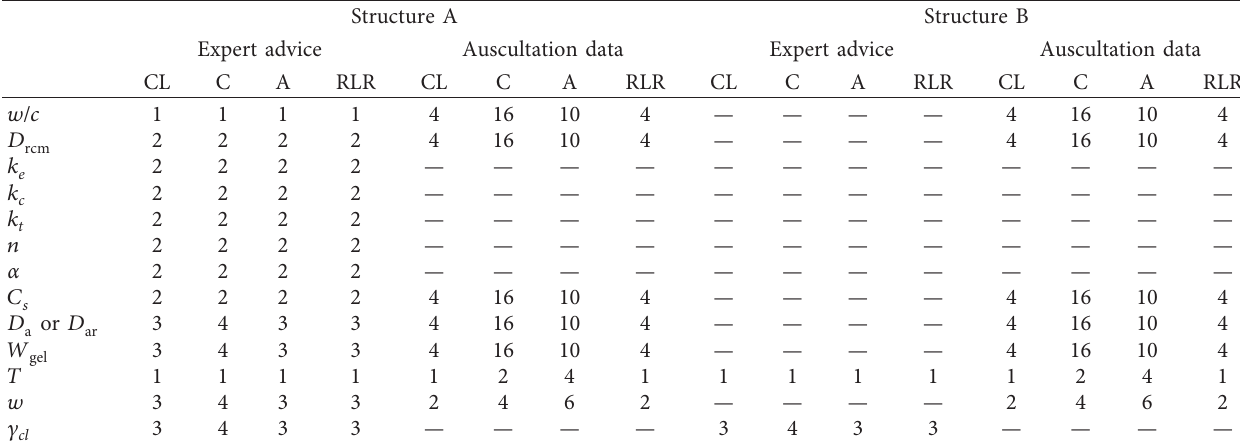
Table 15: Complexity level (CL), cost (C), accuracy level (A), and the level of robustness loss risk (RLR) with respect to structures A and B and for the input parameters of chloride ingress